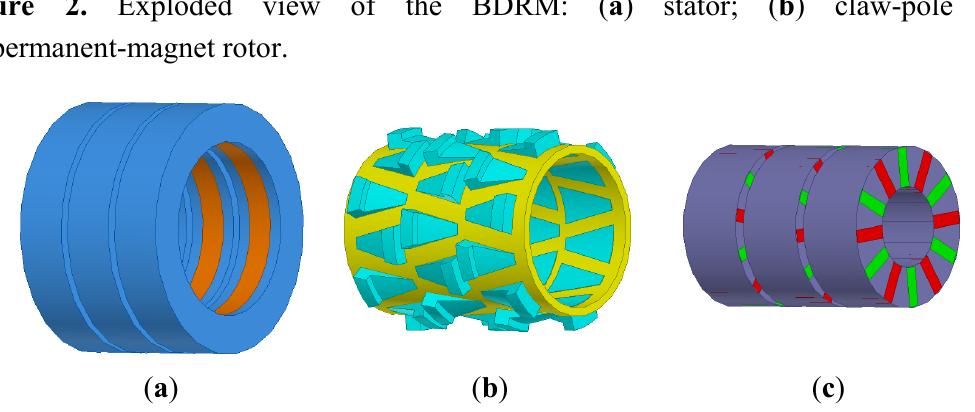
Figure 2. Exploded view of the BDRM: ( a ) stator; ( b ) claw-pole rotor; ( c ) permanent-magnet